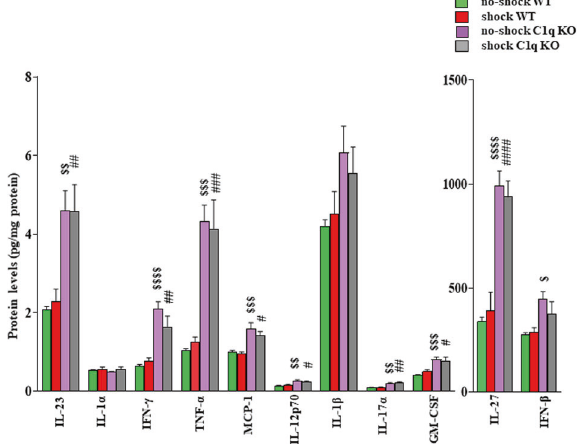
Fig. 4 C1q deletion is associated with increased levels of pro- in fl ammatory cytokines in the PFC. IL-23. Two-way ANOVA, genotype X treatment interaction (F (1, 23) = 0.06640, p = 0.7989, n = 6 – 7); Tukey ’ s multiple comparisons; $$ p = 0.0056 vs no-shock WT, ## p = 0.0094 vs shock WT. IL-1 α . Two-way ANOVA, genotype X treatment interaction (F (1, 23) = 0.2762, p = 0.6043, n = 6 – 7); Tukey ’ s multiple comparisons- no signi fi cant difference between the groups. IFN- γ . Two-way ANOVA, genotype X treatment interaction